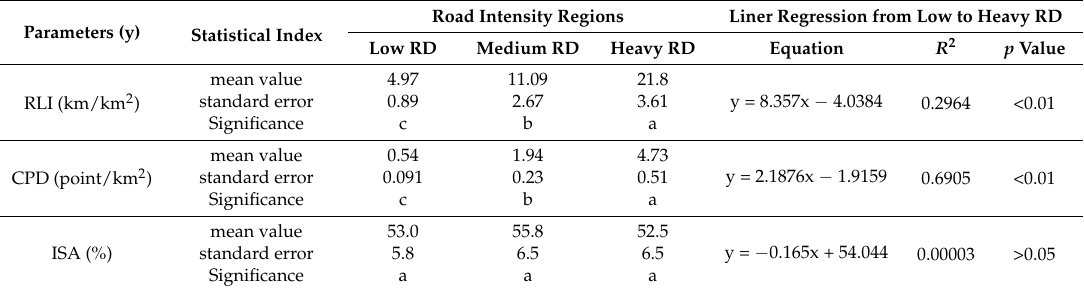
Table 2. Characterization of the study object at different density levels.